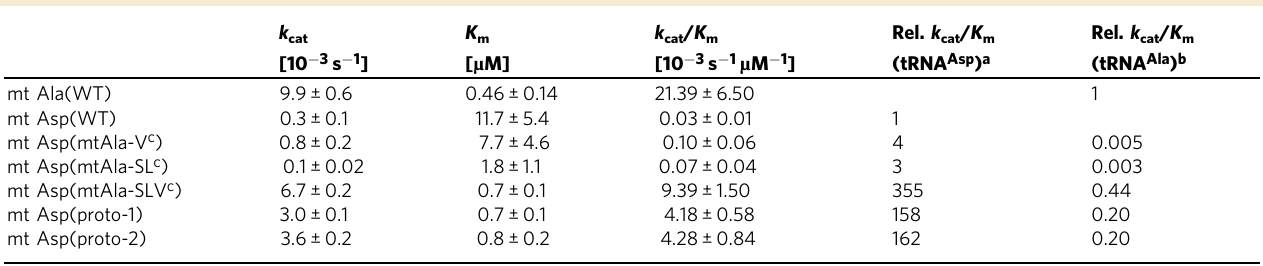
and puri fi ed using the same method. The quality of each protein puri fi cation was validated by SDS-PAGE analysis. The gene coding for Hs mt SerRS was cloned into BamHI/XhoI sites of pGEX- 6P1 vector. Expression and puri fi cation procedures were essentially the same as for mt AlaRS, with the exception that GSH-sepharose beads were used in the initial af fi nity puri fi cation step instead of Ni-NTA. Constructs of Hs mt C-Ala were cloned into BamHI/XhoI sites of pGEX-6P1 vector (Amersham). All three constructs were transformed into E. coli BL21(DE3) cells and expressed as N-terminal GST-fusions as described above. Fusion proteins were fi rst puri fi ed by GSH-sepharose beads (GE Healthcare), followed by the removal of the GST-tag by Prescission Protease (GE Healthcare) digest. The cleaved protein was further puri fi ed by HiTrap Heparin column, and a HiLoad 16/ 60 Superdex 200 column equilibrated in 10 mM HEPES pH 7.5, 100mM NaCl, and 1mM DTT. Puri fi ed C-Ala constructs were concentrated to 10 – 15mg/mL and stored at − 80°C.